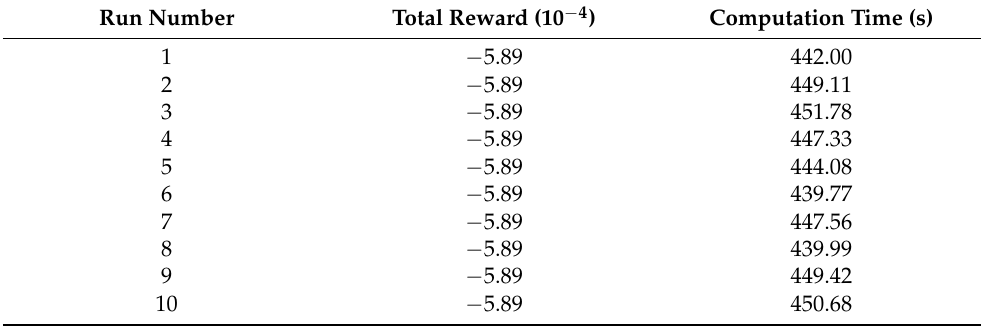
Table 6. Total reward value for all agents and computation time in multiple